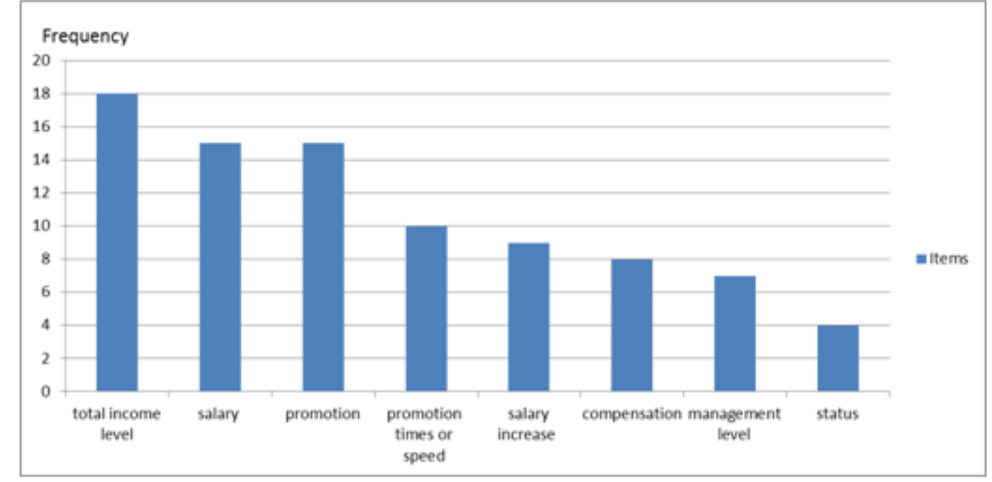
Figure 1. The evaluation index statistics of objective career success from Arthur et al.